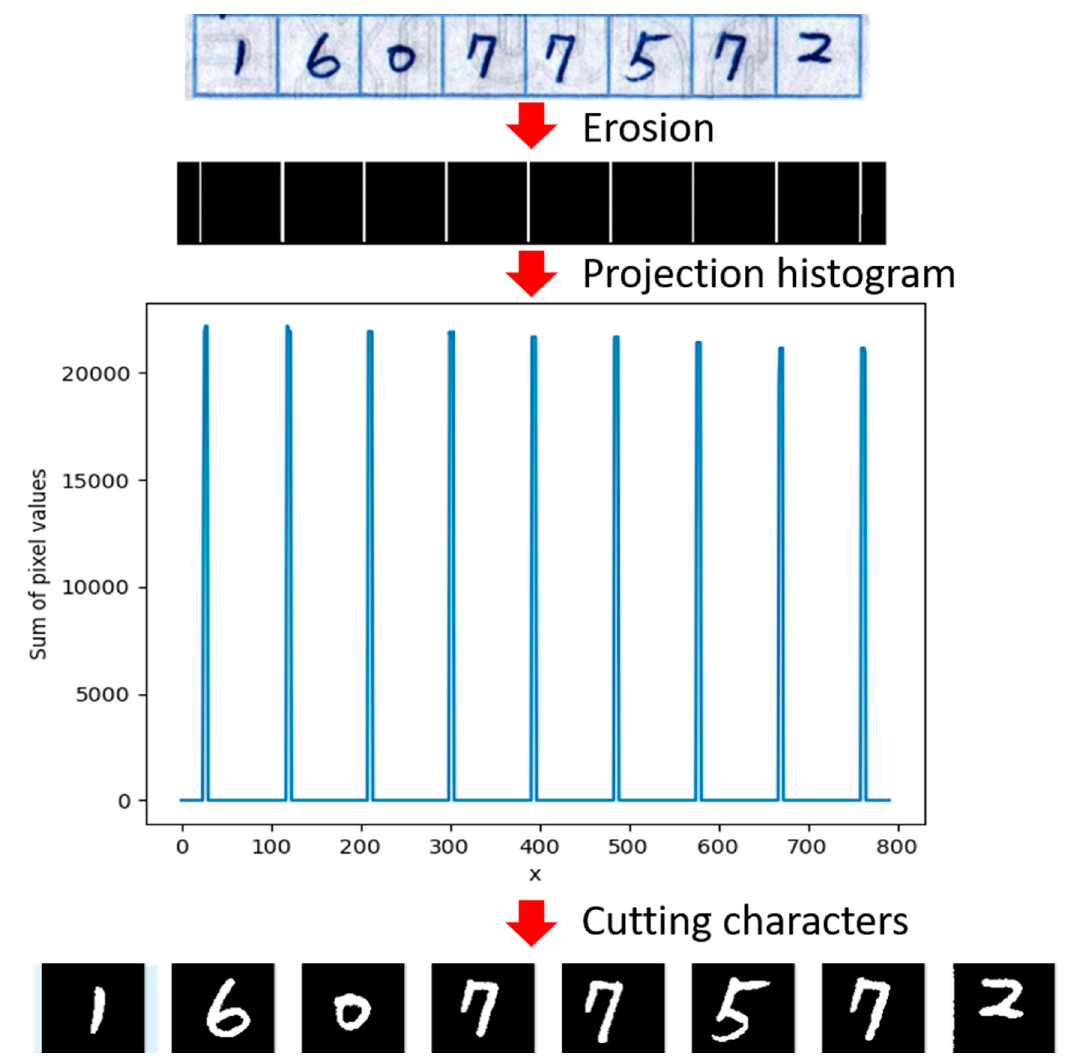
Figure 17. Projection and segmentation results .